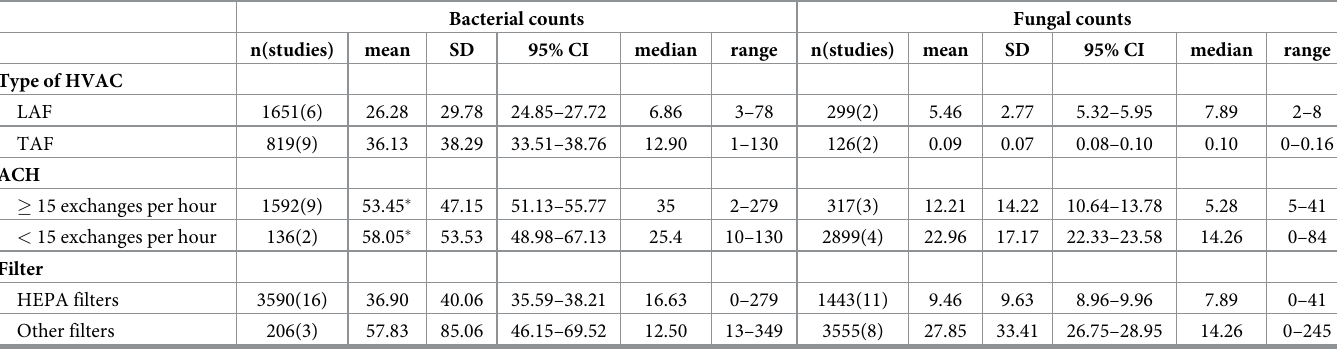
Table 5. Mean colony forming units per cubic meter (CFU/m 3 ) sampled from all of the areas.